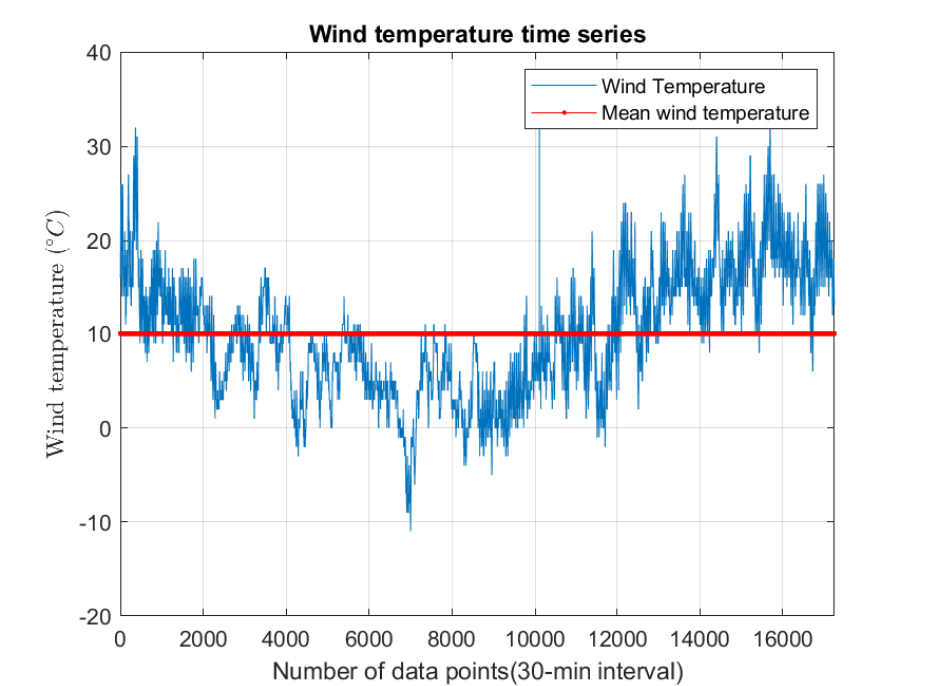
Figure 16. The portraits of wind temperature in OSWFs in Yangshan port, Shanghai from 22 August 2017 to 22 August 2018.